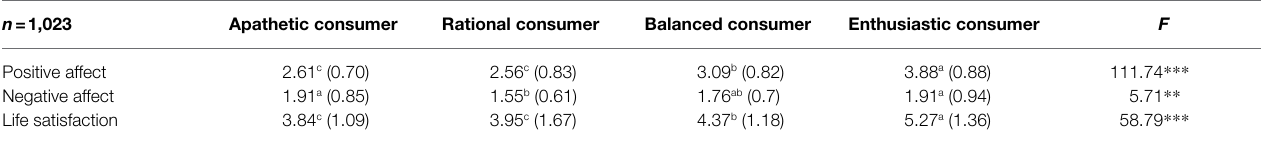
TABLE 7 | ANOVA of subjective well-being. n =